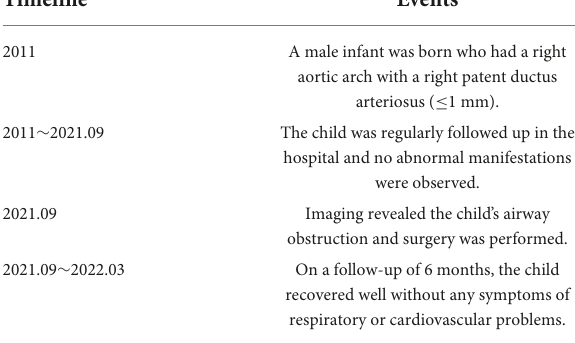
TABLE 1 Timeline of